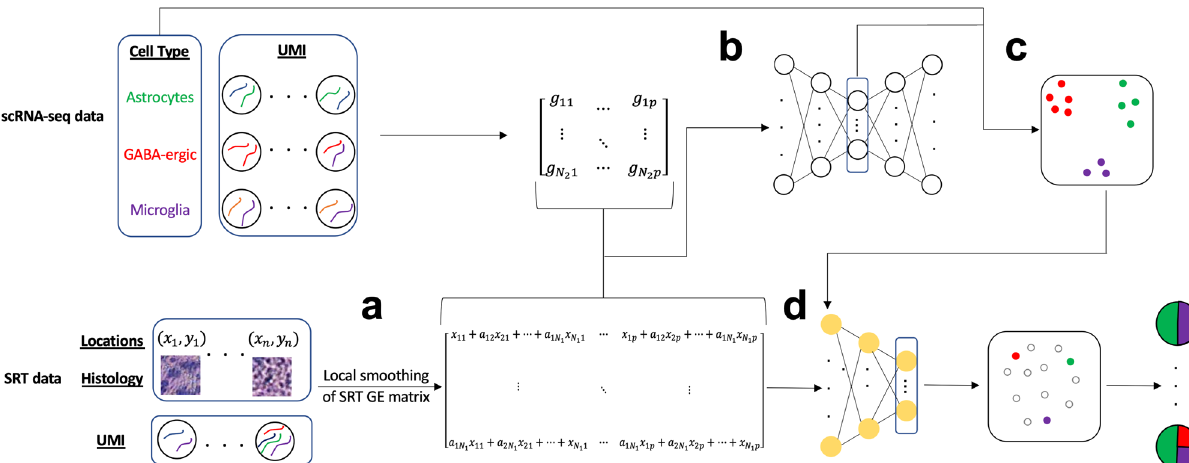
Fig. 1 SpaDecon work fl ow. a Using the SRT high-resolution histology image and spatial locations, SpaDecon constructs an adjacency matrix to locally smooth the SRT gene expression matrix. b The smoothed SRT gene expression matrix is combined with the gene expression matrix of an annotated scRNA-seq reference dataset and used as input for a stacked autoencoder. c A clustering layer is added to the fi nal encoder layer and the annotated scRNA-seq data are used to train the network to identify features relevant for cell-type classi fi cation. d The smoothed SRT gene expression matrix is used as input for the optimized network and cell-type proportions for a spot are inferred using the distances between the embedding for that spot and the centroids representing the cell types present in the scRNA-seq